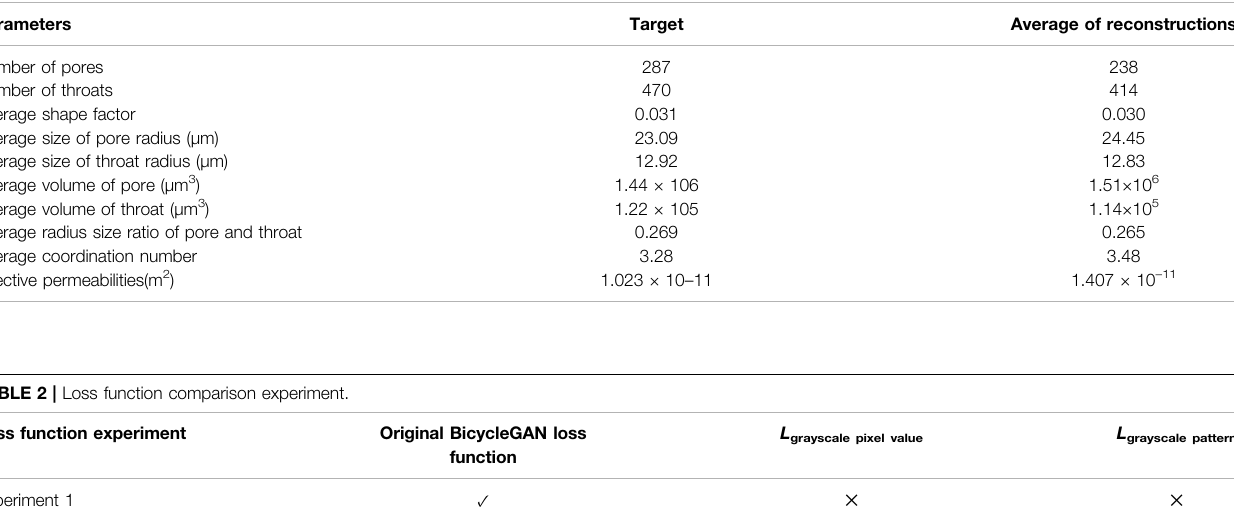
TABLE 1 | Comparison of the morphological parameters.